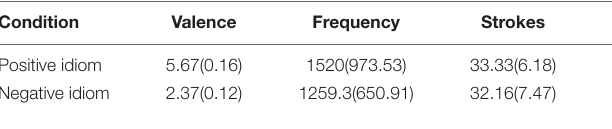
TABLE 1 | Characteristics of Chinese emotion idiom in the experiments.